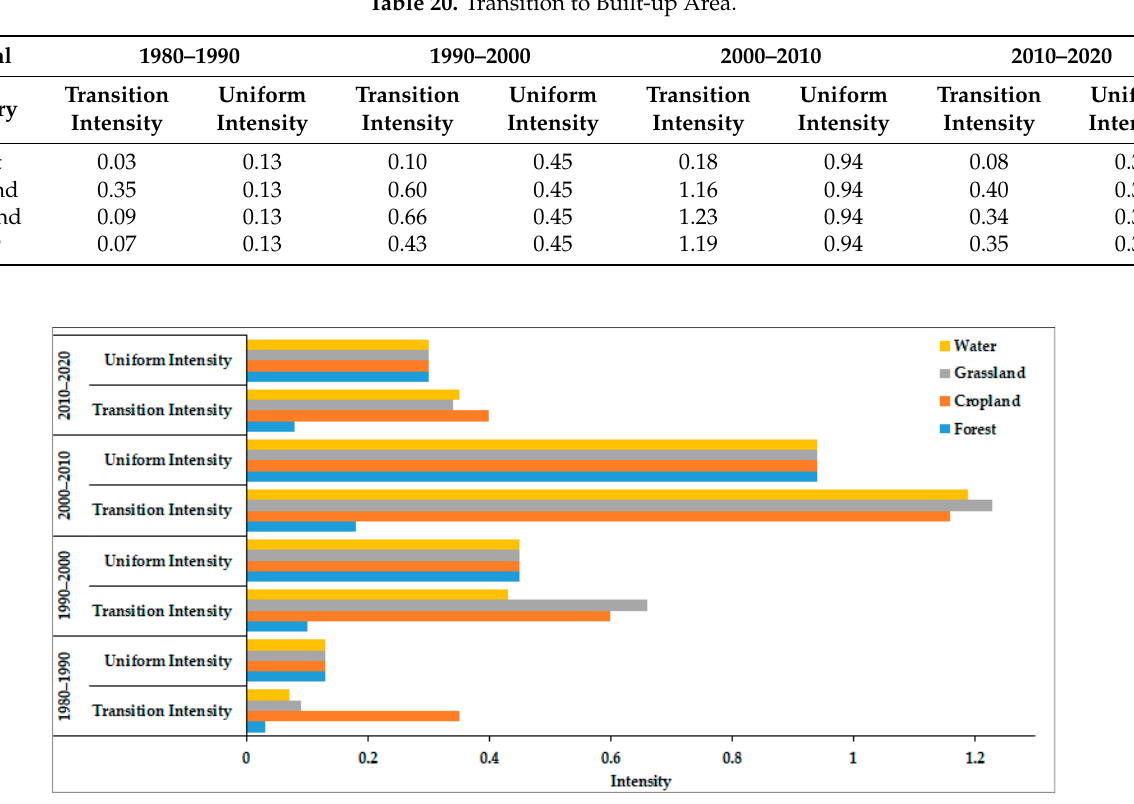
Figure 11. Transition to Built-up Area.